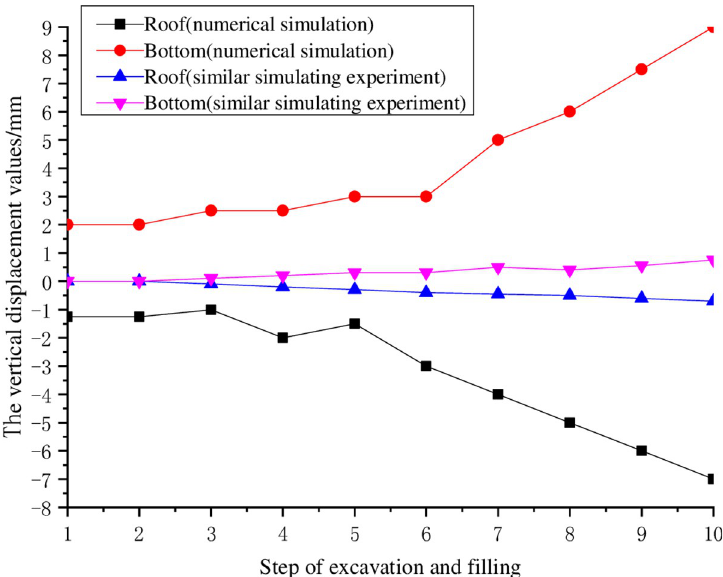
Fig 9. Comparison between the numerical simulations and similar simulation experimental results (H = 700, λ = 2).